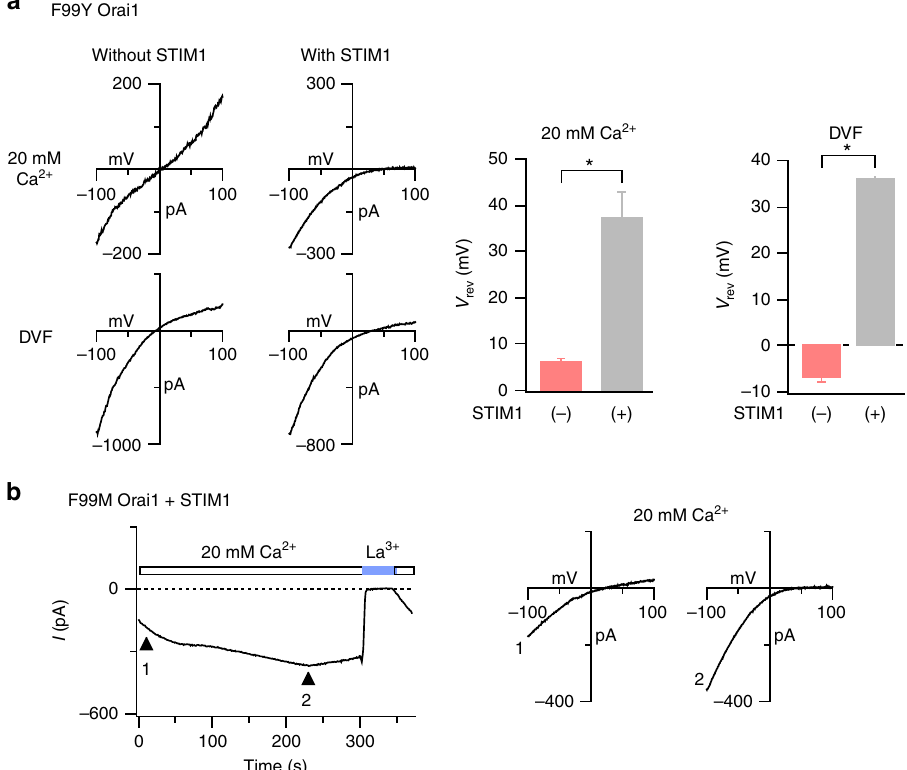
Figure 6 | STIM1 regulates the ion selectivity of the constitutively active F99 mutants. ( a ) Current–voltage ( I – V ) relationships of F99Y Orai1 currents in 20mM [Ca 2 þ ] 0 and in DVF Ringer’s solutions. The bar graphs summarize V rev in the presence or absence of STIM1. This change in V rev is consistent with increase in Ca 2 þ selectivity and decrease in Cs þ permeability 21 . N ¼ 5 cells for each condition. * ¼ P o 0.001 (Student’s t -test). Values are mean ± s.e.m. ( b ) Time-dependent change in the ion selectivity of the F99M mutant following whole-cell break-in. Intracellular stores were depleted by dialyzing the cell with 8mM BAPTA. The left graph plots the time-course of the development of I CRAC at -100mV and the right graphs show the I – V plots at the times indicated by the arrowheads. Time zero represents the moment of whole-cell